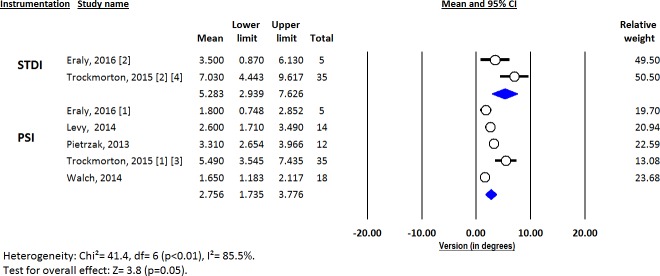
Forest plot of version deviation from the pre-operative planning, for cadaveric studies.